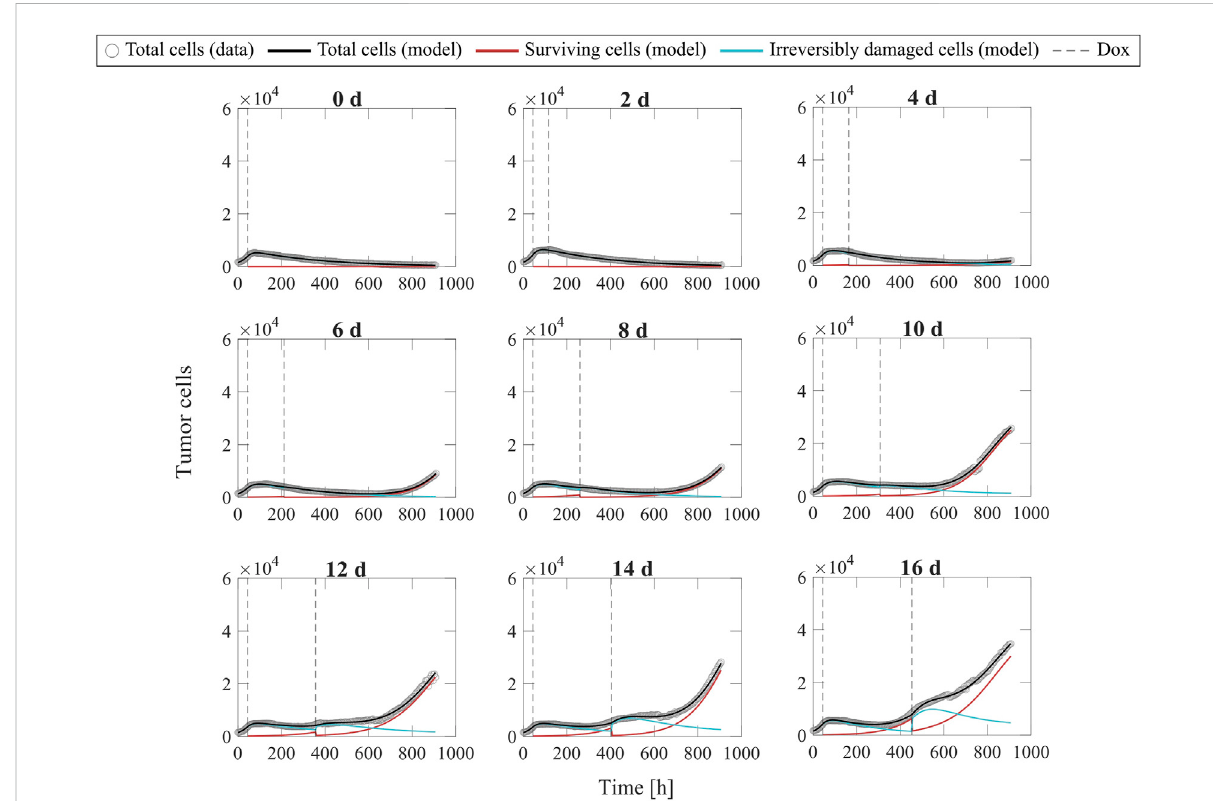
FIGURE 6 Representative fi ts of the multiple-dose model for varying inter-treatment intervals. Data and model fi ttings are shown for a representative replicate exposed to two doses of 75 nM doxorubicin delivered at inter-treatment intervals ranging from 0 to 16 days (Experiment 2, Table 1). Experimentaldataareshowningraycircles.Thenumberoftotalcells,survivingcells,andirreversiblydamagedcellsobtainedwiththe fi ttedmultiple- dosemodelareshown inblack, red,andbluesolidlines, respectively. The times ofdoxorubicin (Dox)delivery arerepresented withverticalgrey dashed lines. Forthe 0-day case, a single line represents a continuous treatmentwith no interval betweenthe doses. Forinter-treatment intervalsof 0 – 6 days, the multiple-dose model with constant parameters was used for data fi tting. For inter-treatment intervals of 8 – 16 days, we used the multiple-dose model with varying f s and γ d . As the inter-treatment interval is lengthened, we observe an increase in the proliferation rate of the surviving cells and a slower transition from proliferation to treatment-induced death in the irreversibly damaged cells. These drug-induced effects ultimately lead to a tumor cell populationrelapse after thesecond dose for inter-treatment intervals of 6 days or longer in most replicates, as well as tumor cell population regrowth after the fi rst dose for inter-treatment intervals of 12 days or longer. These observations suggest increasingly poor tumor control as the two doses of 75 nM of doxorubicin are spaced further out in time. The median and range of the quality of fi t metrics across all datasetsinExperiment2( n =108,Table1)areNRMSE:4.64[2.74,14.3], R 2 :0.99[0.80, > 0.99],PCC: > 0.99[0.91, > 0.99],andCCC:0.99[0.90, >